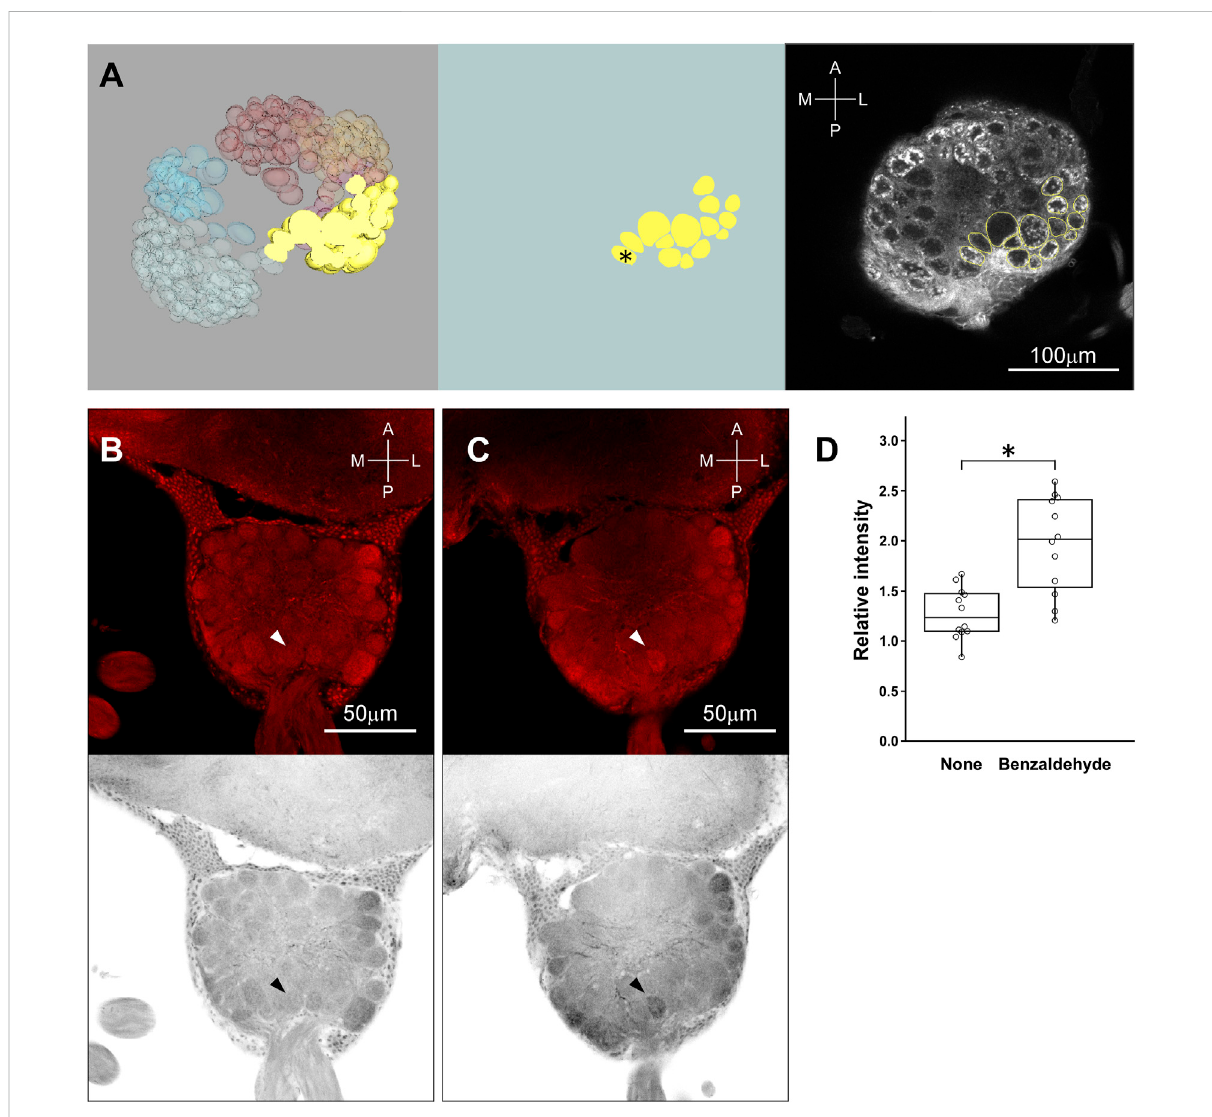
Identi fi cationofglomerulusactivatedbythestimulationwithbenzaldehydevapor. (A) (Left)AfrontalsectionofT2isimplantedinthedorsalpart of reconstructed 3D glomerular model. (A) (Middle) A part of T2 glomeruli is extracted to identify the activated one. Asterisk indicates the candidate glomerulus activated by the vapor stimulation with benzaldehyde. (A) (Right) The contoured glomeruli of (A) (middle) were superimposed on the confocal image. (B) (Top, Bottom) The original image of AL at the level of T2 region under non-stimulated condition and its inverted gray scale imageareindicated, respectively. (C) (Top,Bottom) Therepresentative originalimageofAL atthelevel ofT2region with theglomerulusactivated by thevapor stimulation with benzaldehyde. Arrowheadsindicate thelocation oftheglomerulus activated by thevapor stimulation with benzaldehyde. (D) Comparison in brightness of the identi fi ed glomerulus between non-stimulated and stimulated conditions. Asterisk indicates signi fi cant difference ( p < 0.05, Mann-Whitney ’ s U